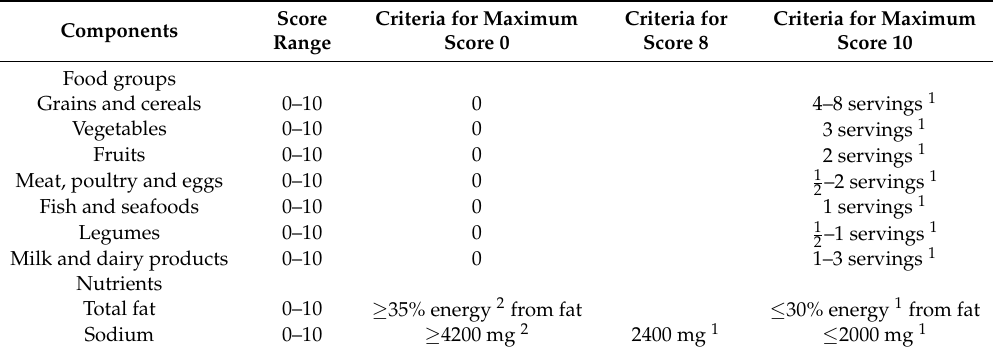
Table 1. Criteria scoring for Malaysian Healthy Eating Index components.